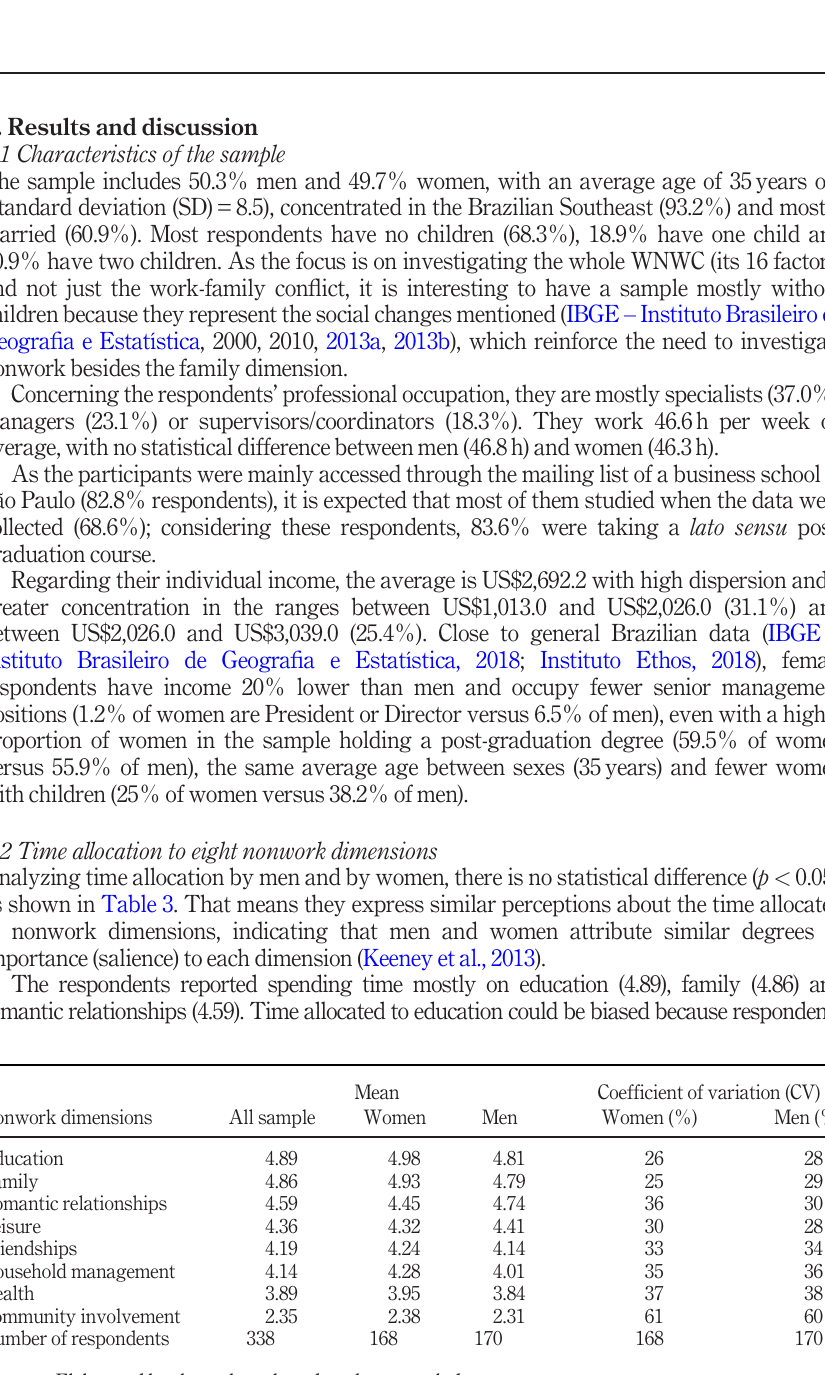
different nonwork dimensions: highlighting